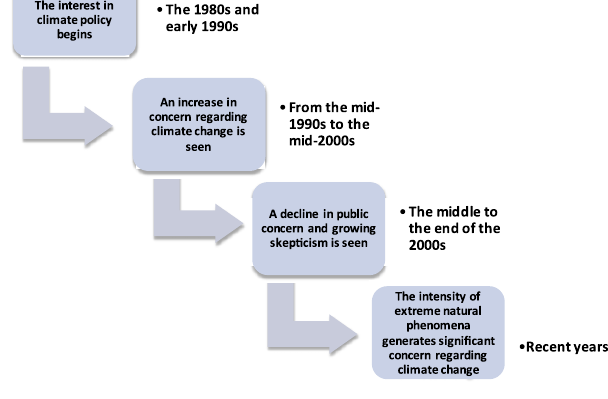
Figure 1. Trends in studies